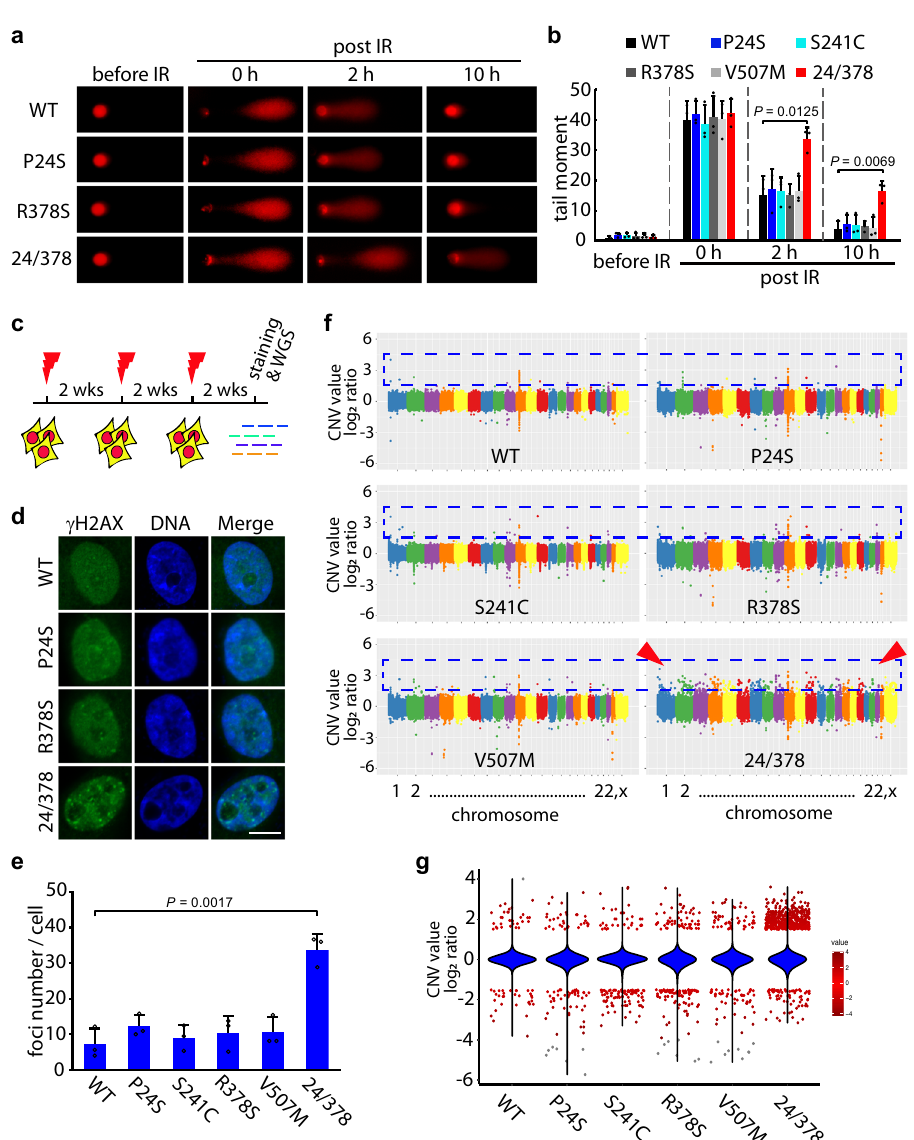
Fig. 5 P24S/R378S double mutation causes genome instability. a Comet assay of MCF10A cells expressing WT BARD1 or different BARD1 variants. IR- treated cells at different time points were harvested and subjected to neutral comet assays. b Comet assay summary of MCF10A cells from a . Tail moments of cells represent data from three independent experiments, with at least 30 cells in each group. Data are presented as mean values ± SD. P values are calculated by unpaired two-tailed Student ’ s t tests. c Experimental design for the IR/recovery experiment. MCF10A cells expressing WT BARD1 or different BARD1 variants were treated with three rounds of IR (5 Gy) followed by a 2-week recovery phase after each treatment. After the third round of recovery, cells were collected for subsequent staining or whole-genome sequencing (WGS). d Immuno fl uorescence staining of γ H2AX in MCF10A cells expressing different BARD1 variants. The treated cells from c were fi xed and stained with an anti- γ H2AX antibody and DAPI. Scale bar, 10 μ m. e Number of γ H2AX foci in cells from d . The foci number in individual cells expressing BARD1 WT or different BARD1 variants was counted. At least 30 cells were included for each group. Three biologically independent replicates were performed. Data are presented as mean values ± SD. P values are calculated by unpaired two-tailed Student ’ s t tests. f , g Whole-genome CNV analysis of MCF10A cells expressing BARD1 WT or different BARD1 variants. Genomic DNA of the treated cells from c was extracted and subjected to WGS, followed by CNV analysis with CNV-Seq. The CNV value of each chromosome (1 – 22, and X) in different cell groups is shown as the log2 ratio of f . Total CNV value for all chromosomes in the different cell groups